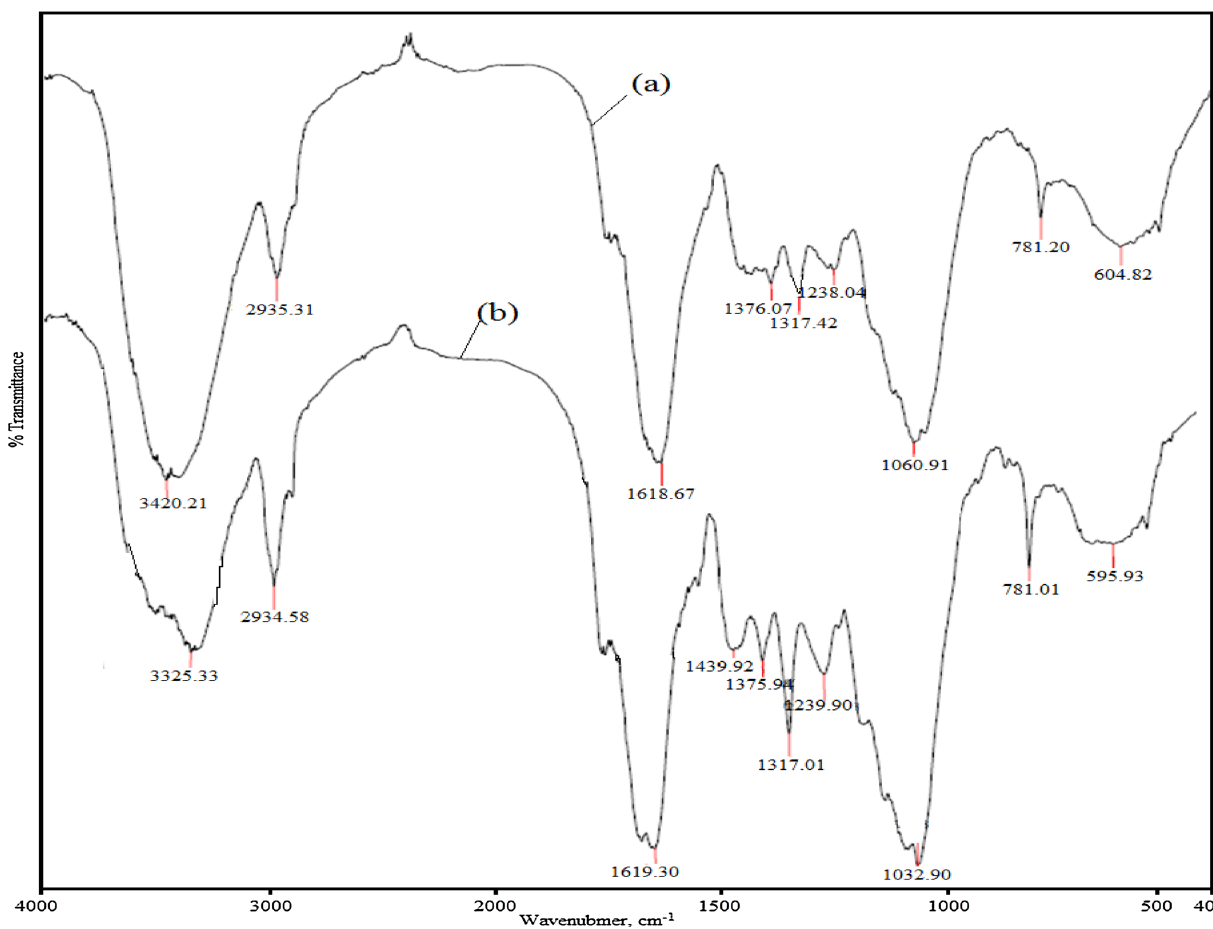
Fig. 4 FT-IR of A. heterophylla a before and b after Cd ? 2